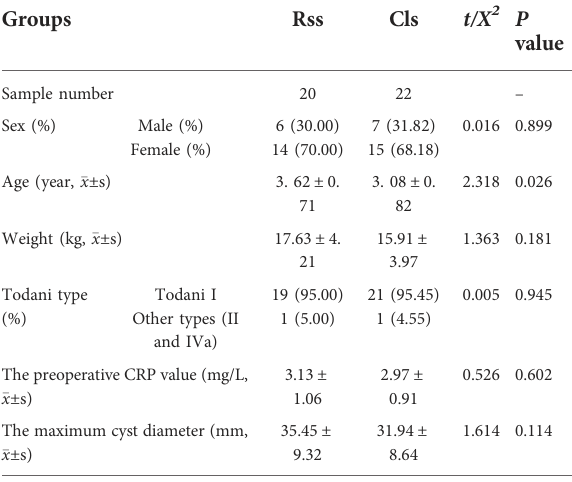
TABLE 1 Comparison of general information and preoperative conditions of the two surgical groups. Groups